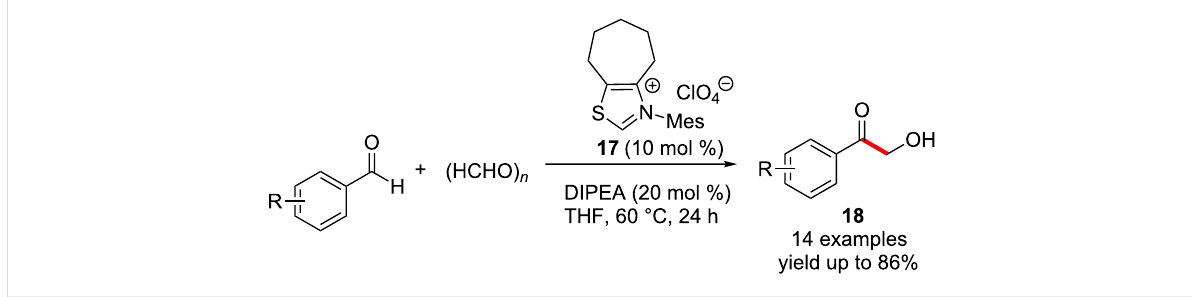
Scheme 8: Cross-benzoin reactions catalysed by thiazolium salt 17 .